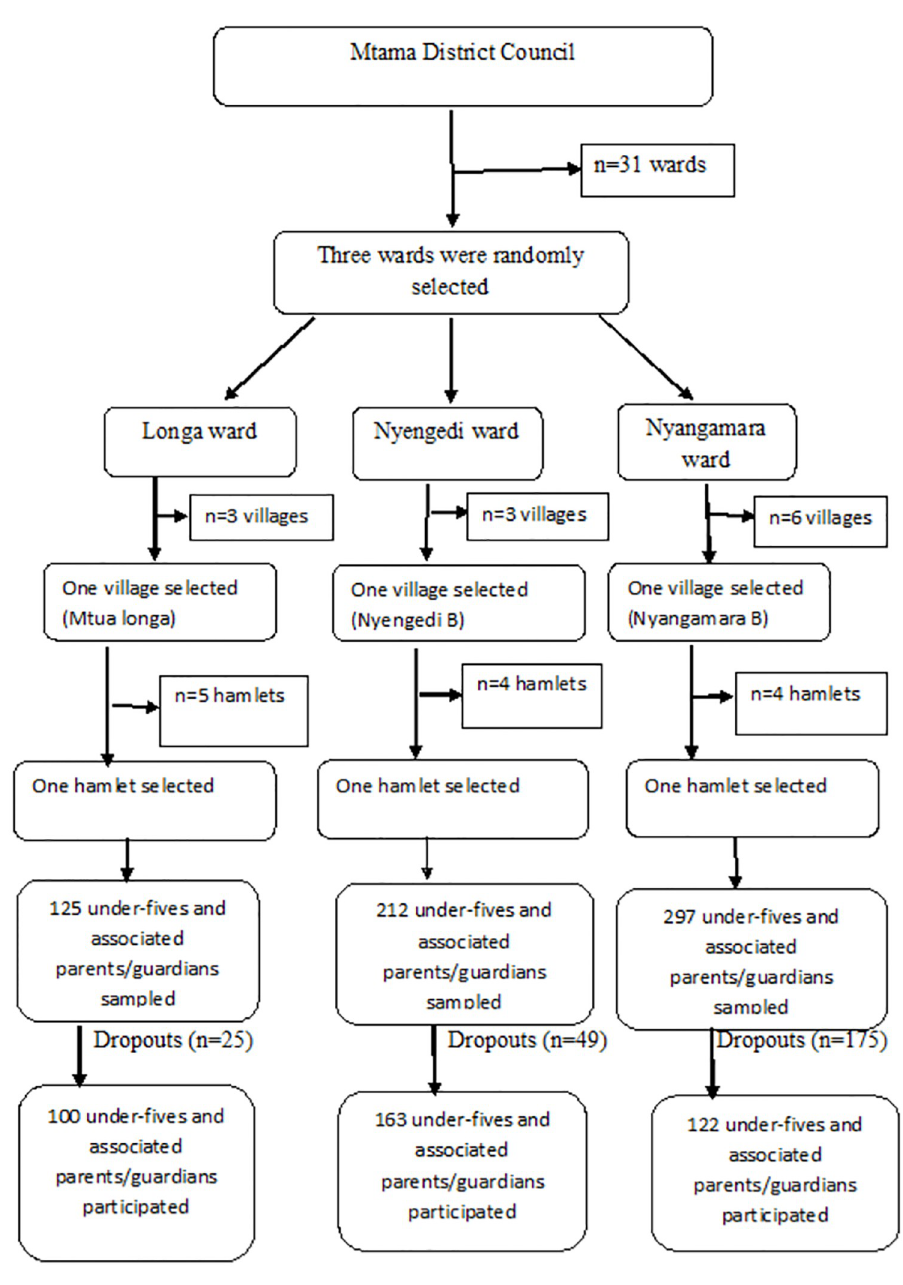
Fig 1. Flow chart of sampling